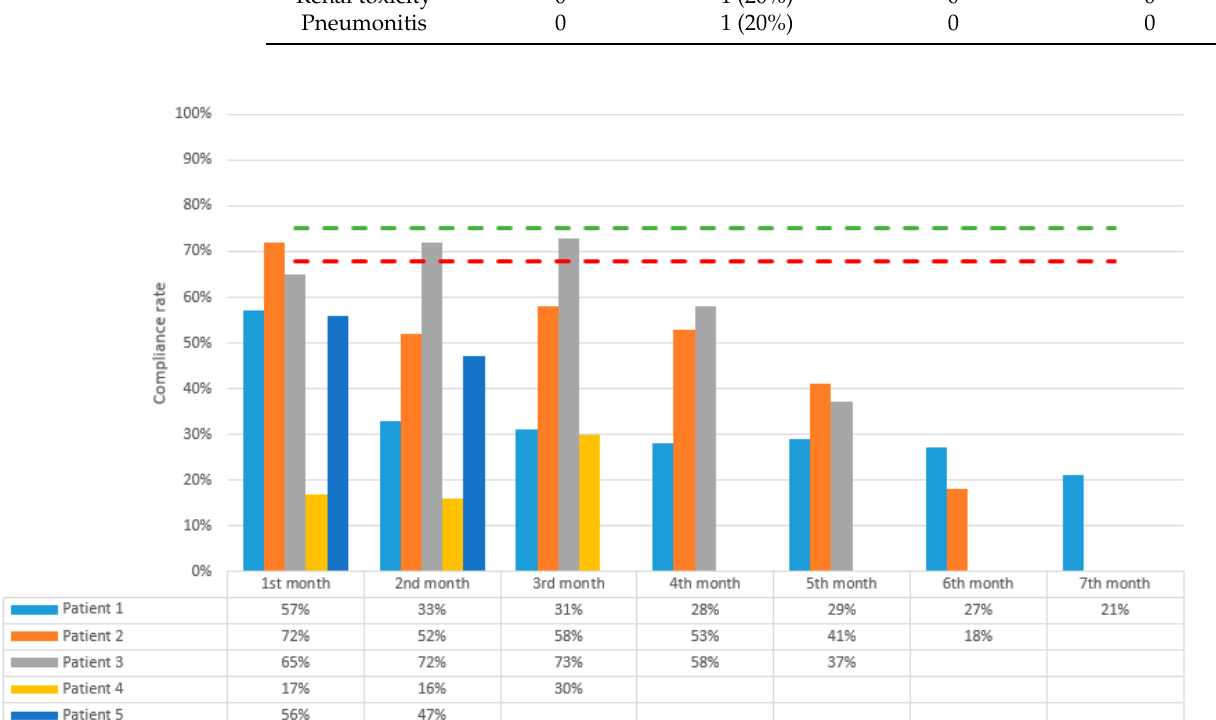
Figure 2. Average daily TTFields device usage percentages by month. The device usage rates recommended by company (green) and recorded by STELLAR study (red) are indicated by the dashed lines.